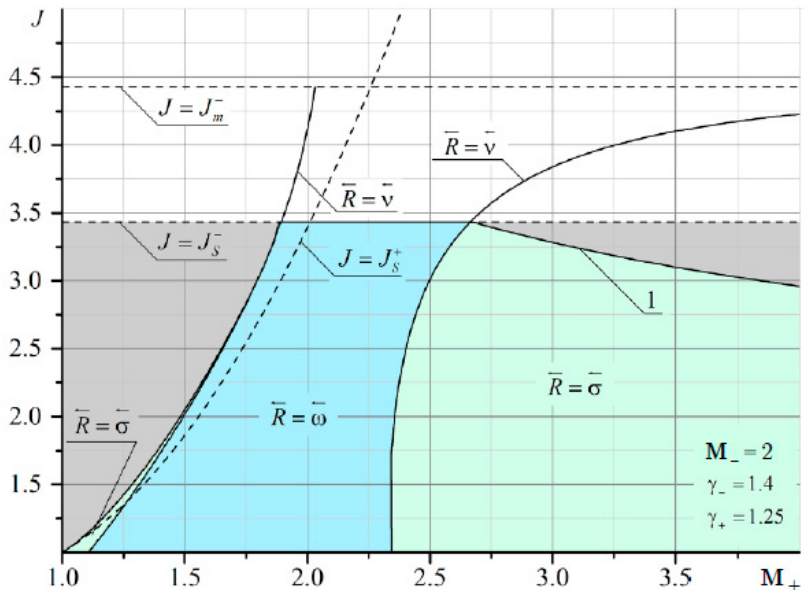
Figure A13. Domains of existence of reflected discontinuities for refraction from a diatomic gas into a gas consisting of combustion products. The Mach number of the flow from which the shock comes is M – = 2. The domains of existence of reflected discontinuities for refraction from a diatomic gas into a gas consisting of combustion products at the Mach number of the flow M – = 3 are shown in Figure